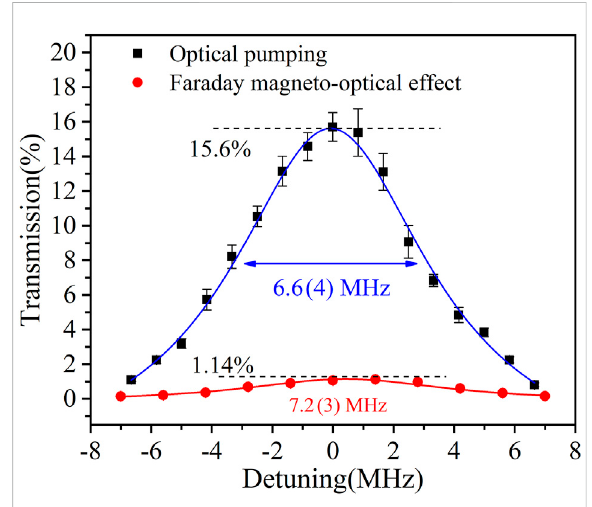
FIGURE 4 Transmission spectrum of the cold-atom optical fi lter (corresponding to F =2 → F ′ =2 transition). The black square points represent the transmission spectrum of the cold-atom optical fi lter realized by optical pumping method. The red circular points represent the transmission spectrum of the cold-atom optical fi lter realized by Faraday magneto-optical effect. The blue and red curves are the Lorentz fi tting curves respectively. Each point is obtained by averaging 20 measurements.